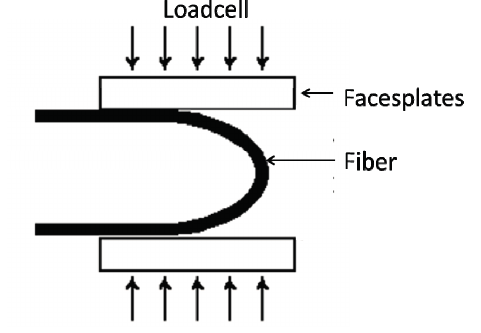
Figure 2. Schematic representation of the two-points bending